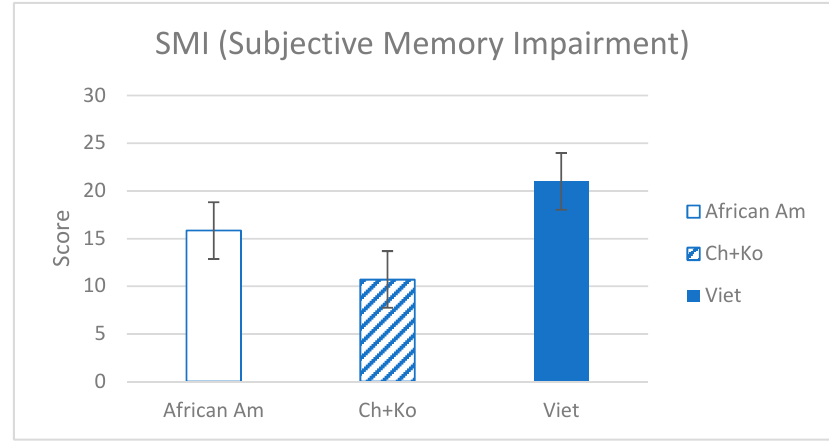
Figure 1. Subjective Memory Impairment by Ethnic Groups.